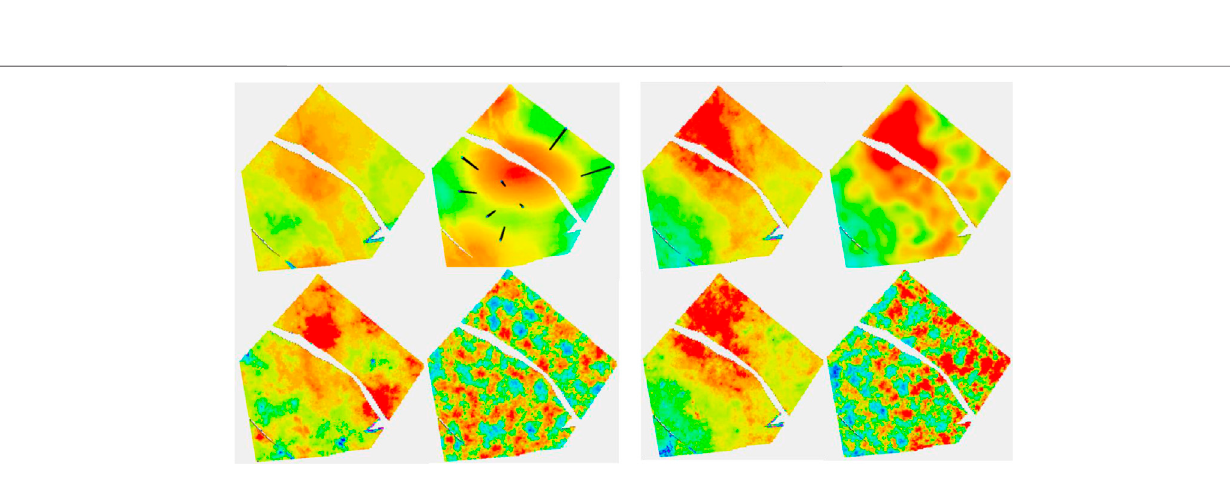
Frontiers in Arti fi cial Intelligence |